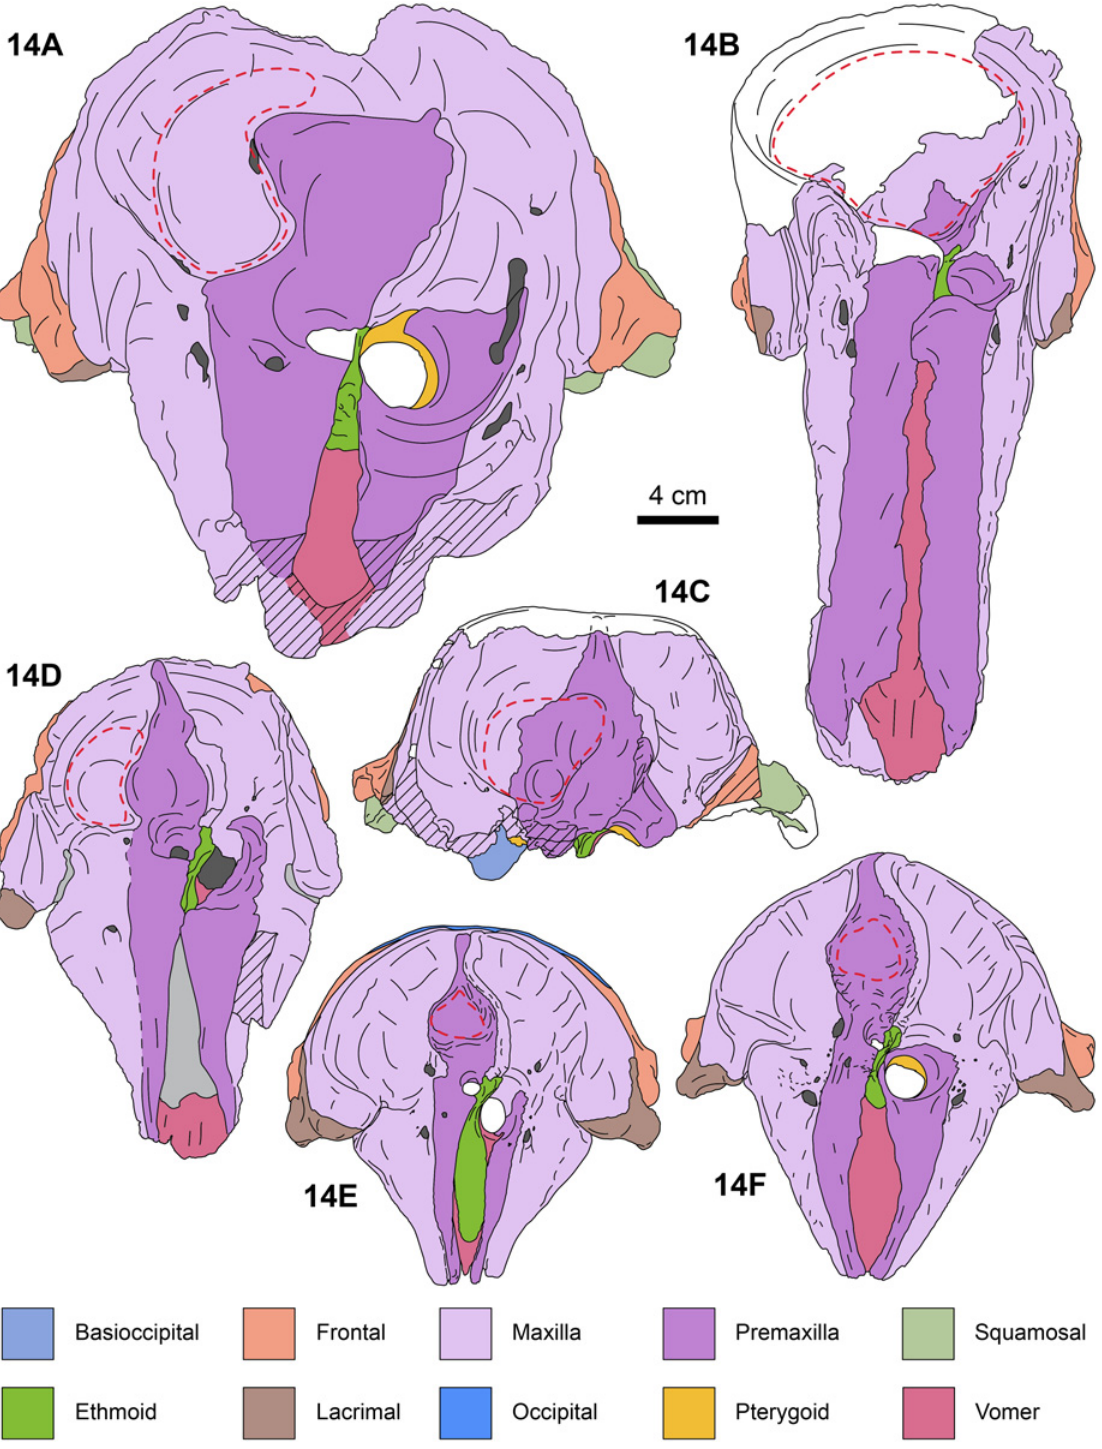
Fig 14. Anterodorsal views of kogiid skulls. Aprixokogia kelloggi (USNM 187015), 14A, Scaphokogia cochlearis (MNHN PPI 229), 14B, Praekogia cedrosensis (UCMP 315229), 14C, Nanokogia isthmia gen. et sp. nov. (UF 280000), 14D, Kogia sima (LACM 47142), 14E, and K . breviceps (LACM 95745), 14F; each bone is color-coded for ease of comparison. Red dashed lines denote the extent of the supracranial/premaxillary fossa. Areas in white are reconstructed, light gray areas are covered with sediment; diagonal lines denote broken surfaces.